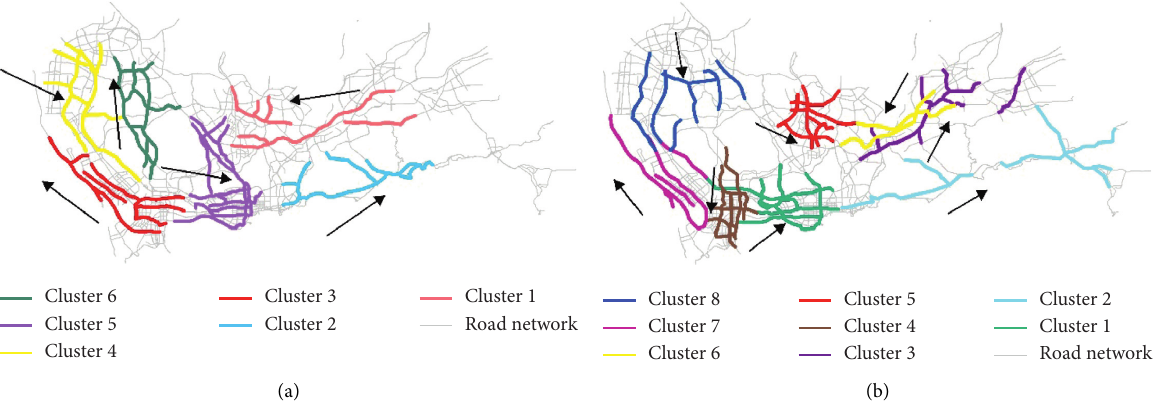
Figure 6: Clustering results: (a) workday and (b) weekend. Table 3: Detailed information of each cluster on workday.